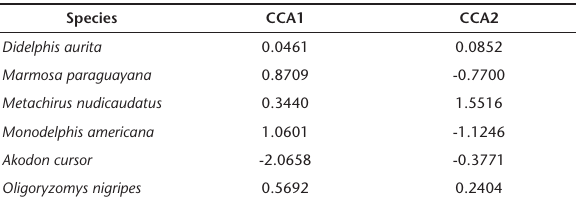
Table 5. Canonical Correspondence Analysis scores for the small mammals analyzed for the 2012-2015 period in CFMA, Rio de Janeiro, Brazil.